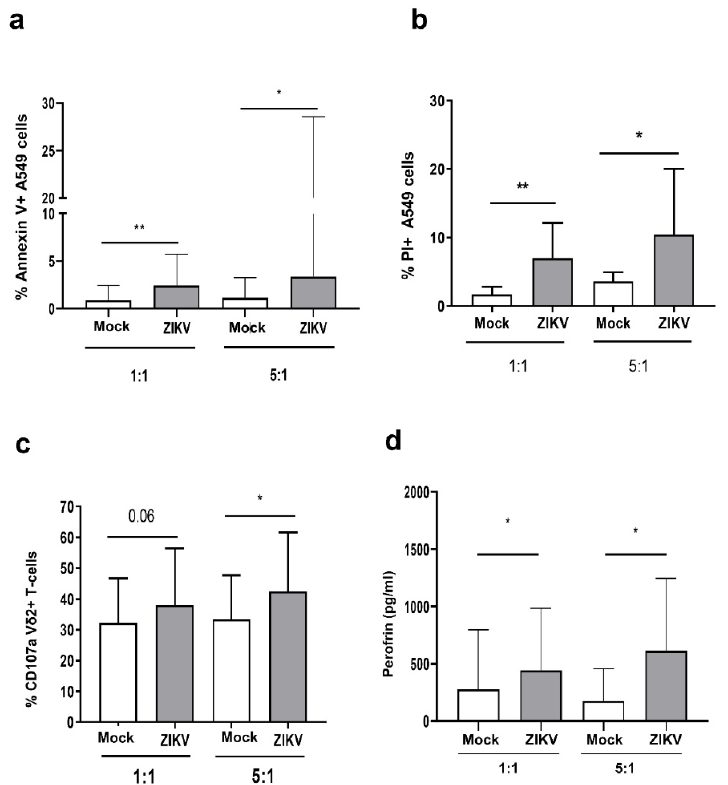
Figure 2. ZIKV sensitized A549 cells to V δ 2 T-cell-mediated killing. ( a – c ) Expanded V δ 2 T-cells were cultured overnight with mock (white bars) or ZIKV-infected A549 cells (grey bars) cells, at 1:1 and 5:1 ratios. ( a , b ) After 18 h, apoptotic / necrotic A549 cells were analyzed by measuring AnnexinV and PI expression by flow cytometry ( n = 15). ( c ) The frequency of V δ 2 + / CD107a + cells was measured after the culture with mock / ZIKV-infected cells ( n = 7). ( d ) Perforin quantification in the supernatants of the same experiments was shown. In all experiments, background (mock / ZIKV + apoptotic / necrotic cells without expanded V δ 2 T-cells) was subtracted to all conditions. Data were represented as median + interquartile range. * p < 0.05; ** p <